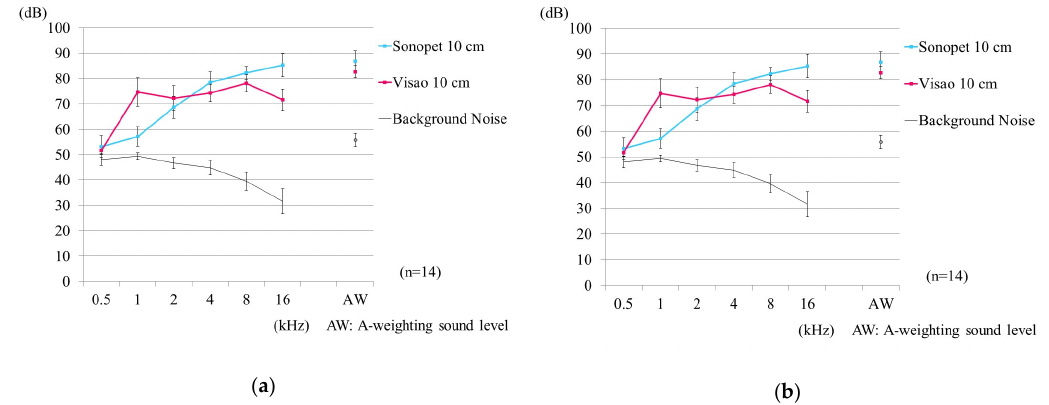
Figure 8. ( a ) Air-conducted noise levels measured at 10 cm from the tip of the tool; ( b ) Air-conducted noise levels measured at 70 cm from the tip of the